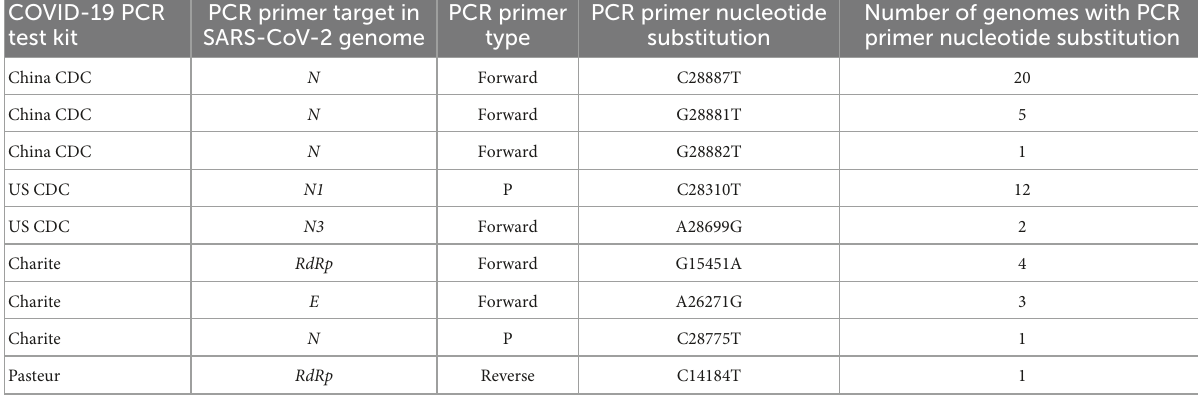
TABLE 3 Coronavirus disease-2019 (COVID-19) polymerase chain reaction (PCR) test kits affected by primer nucleotide